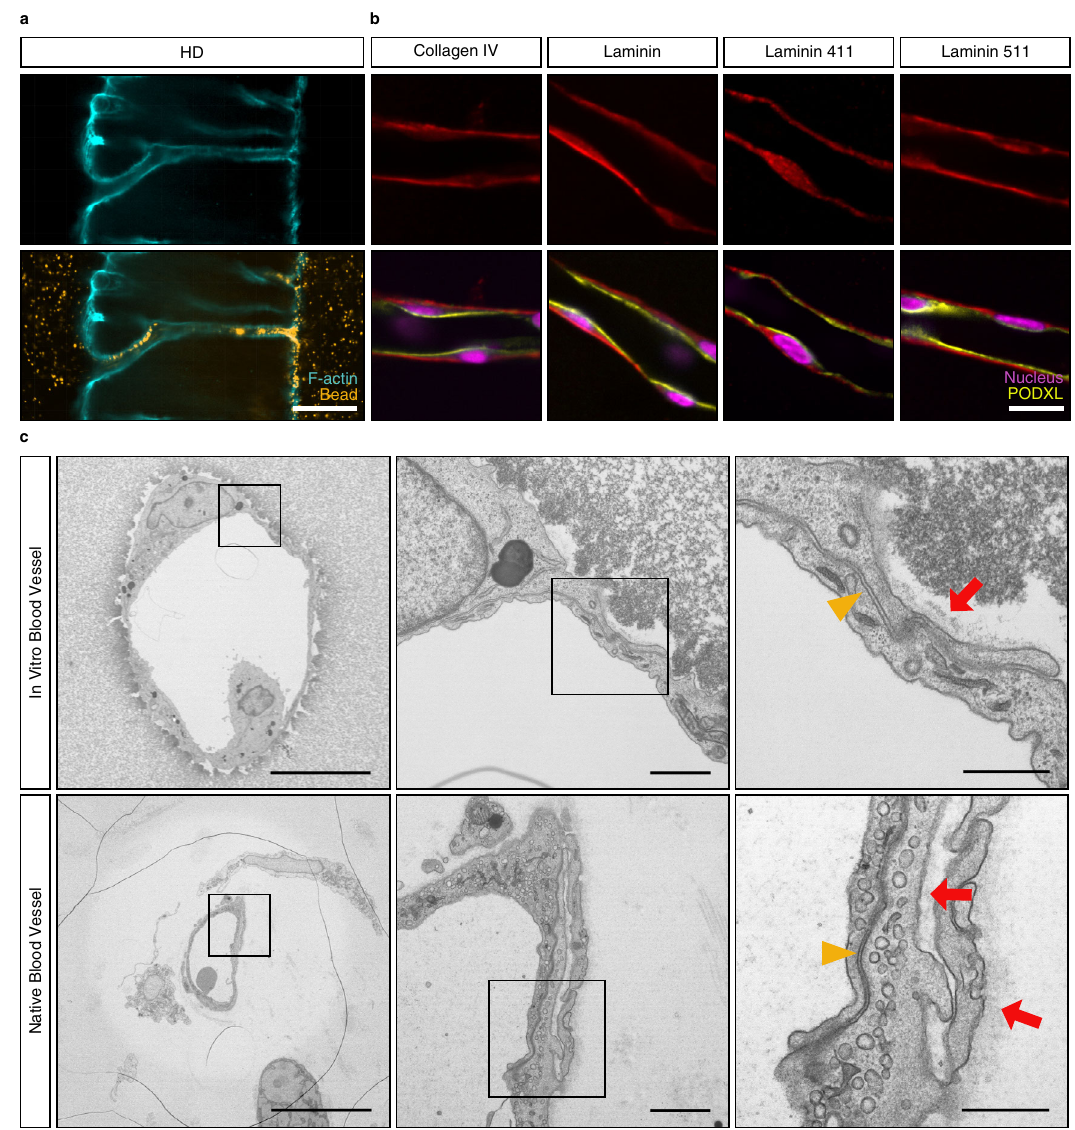
Fig. 5 In vitro vessels display many hallmarks of in vivo blood vessels. a Neovessels connecting parent and growth factor source channels after 3 weeks of culture in the presence of chemokine gradients. Flow through neovessels visualized by the perfusion with 1 μ m diameter fl uorescent beads (scale bar, 100 μ m). b Basement membrane deposition, as visualized by immuno fl uorescence staining for collagen IV, pan-laminin, laminin 411, and laminin 511 (red), in combination with correct apical-basal polarity, as demonstrated by the expression of the apical marker podocalyxin (PODXL, yellow). Nuclei counterstained in magenta. (scale bar, 20 μ m). c Comparison of in vitro and native vessels by electron microscopy reveals strikingly similar morphologies with regards to junctional integrity (yellow triangle), endogenous ECM deposition (red arrow), and cell- fl attening (scale bar, 10 μ m, 1 μ m, 500 nm). All samples contained 12 mM immobilized CGRGDS and 25.2 mM high degradability (HD) adhesive ligands (adjusted to a total concentration of 12 mM using the non- adhesive peptide CGRGES) was prepared in PBS on ice. To initiate the coupling of adhesive ligands to DexVS, the pH of the solution was adjusted to 8.0 using 1 M and 0.1M NaOH. The solution was allowed to react for 30min at room tem- perature, followed by the addition of variable concentrations of crosslinker peptides (25.2 mM NCD-KK for gels in Figs. 2, 3; 25.2 mM NCD-KAK and 25.2 mM HD for gels in Fig. 4; 25.2mM HD for gels in Fig. 5). The solution was again cooled on ice, and the pH was readjusted to 8.0 using 0.2 M NaOH to initiate hydrogel cross- linking. The solution was immediately transferred to the central chamber of the micro fl uidic device and allowed to gel for 30min at room temperature, followed by hydration in PBS.